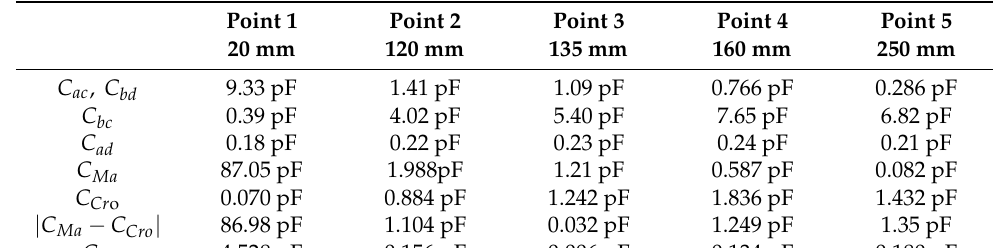
Figure 8. Metal mesh film characteristics. ( a ) Flexibility. ( b ) Transparency.